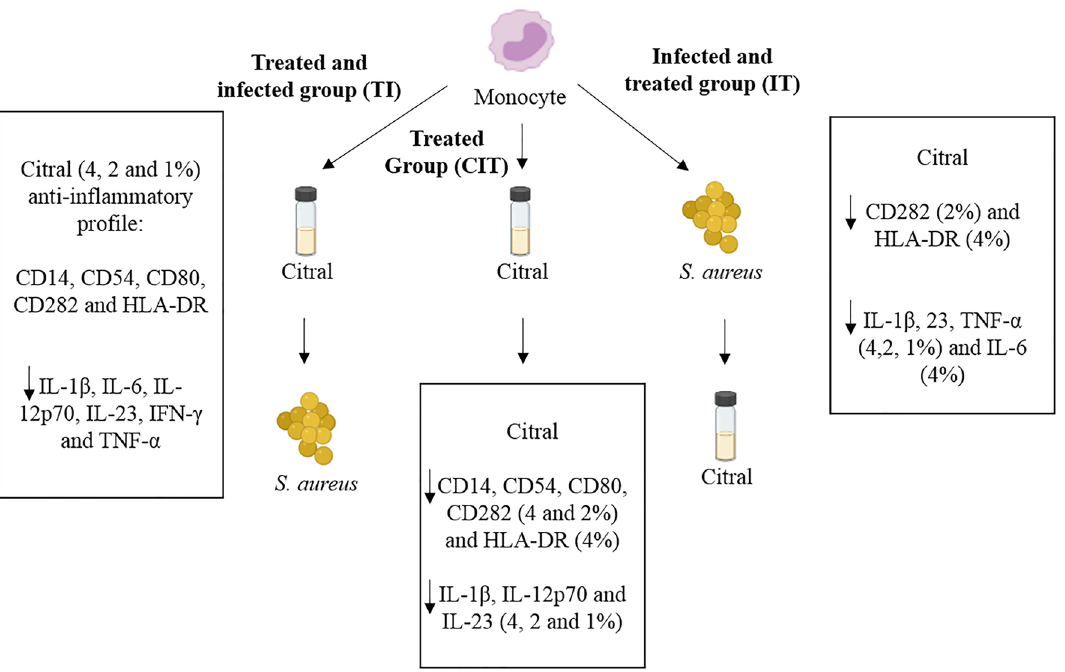
Figure 5. Proposed mechanism of action of citral in groups treated with citral and infected with S. aureus (TI), treated with citral (CIT), and infected with S. aureus and treated with citral